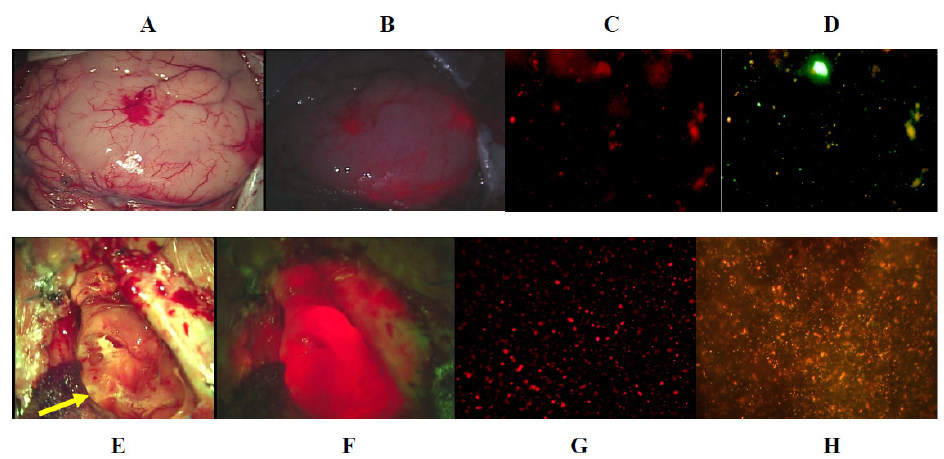
Figure 6. Illustrative case eleven ( A–D ) and case eighteen ( E–H ). ( A ): The tumor tissue in the cortical gyrus of the left frontal lobe showed hypertrophic features. ( B ): Weak fluorescence was detected on photodiagnosis using the surgical microscopy. ( C ): A total of 97 cells emitting fluorescence were detected in the tumor bulk tissue under fluorescence microscopy using the Cy 5 filter. ( D ): Merged images taken using the Cy 5 filter and the PDD-B filter demonstrated a mosaic pattern of fluorescence-emitting and non-emitting cells. ( E ): The recurrent tumor tissue was a nodular cortical mass (yellow arrow). ( F ): Strong fluorescence was observed on photodiagnosis using surgical microscopy. ( G ): A total of 573 cells emitting fluorescence were detected in the tumor bulk under fluorescence microscopy using the Cy 5 filter. ( H ): Merged image of images taken using the Cy 5 filter and PDD-B filter demonstrated a diffuse pattern, with almost all tumor cells emitting fluorescence.